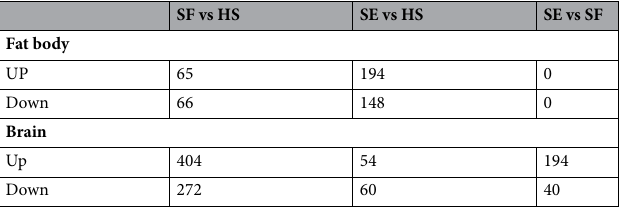
Table 1. Number of differentially expressed genes (FDR < 0.05) between pairwise comparisons of fat bodies and queens from three treatments: Hayes solution-injected queens (HS), queens injected with seminal fluid (SF), and queens injected with semen